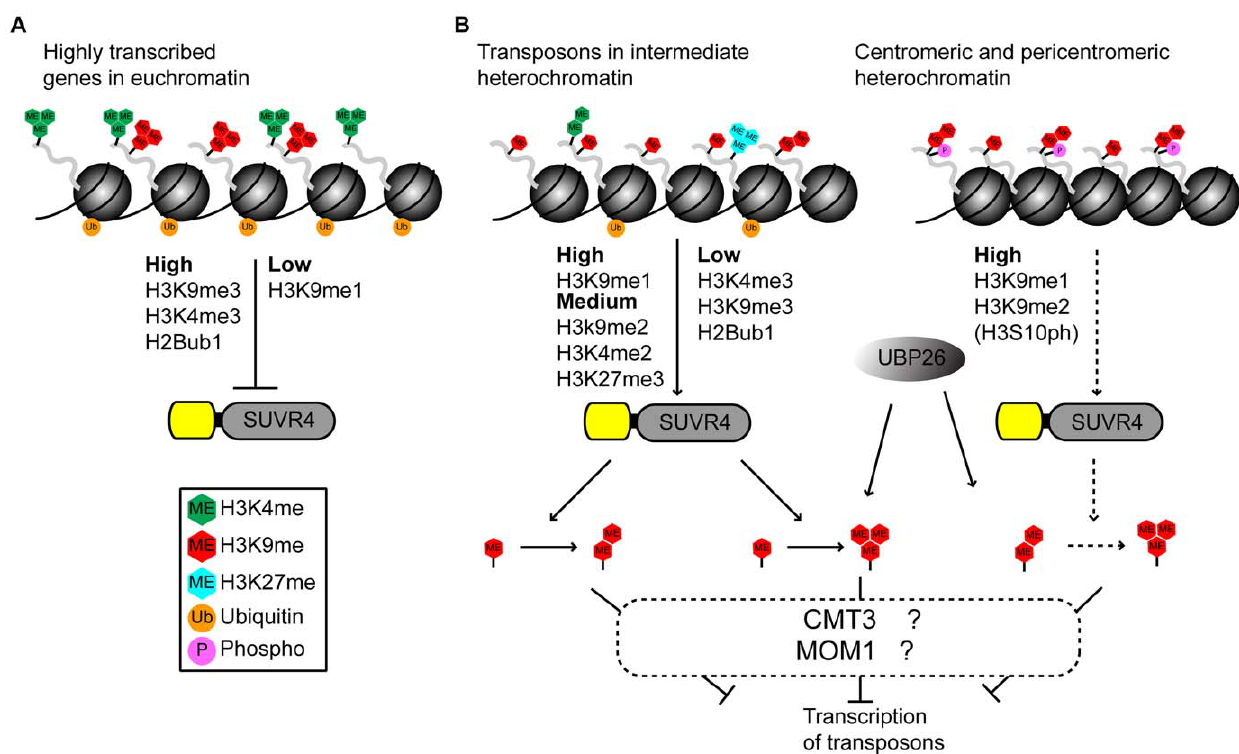
Figure 7. Model describing the relationship between free ubiquitin and SUVR4 activity on transposons. (A) SUVR4 is repressed by H3K4me3 in vitro , and has no activity on genes with high H3K4me3, H3K9me3, H2Bub1 and a low level of H3K9me1. (B) SUVR4 9 s preference for heterochromatic transposons intercalated within euchromatin is maintained by its specificity for H3K9me1 which is highly enriched at transposons, and its repression by activating marks like H3K4me3. The deubiquitinase UBP26 regulates H3K9me2/me3 at the same targets as SUVR4, and might produce free ubiquitin that stimulates the H3K9me2/me3 activity of SUVR4 at target transposons. Although SUVR4 normally is repressed by H3K9me2 and H3S10ph which is high in pericentric heterochromatin, these regions may be targets for SUVR4 activity when ubiquitin levels are high. Since the transposons also contain a medium level of H3K27me3 in addition to H3K9me3, this could possibly create a binding site for CMT3 in order to repress transcription in a DNA methylation-dependent manner at some transposons. At other transposons, transcription may be repressed in a DNA methylation- independent manner by the MOM transcriptional repressor (See text for details).